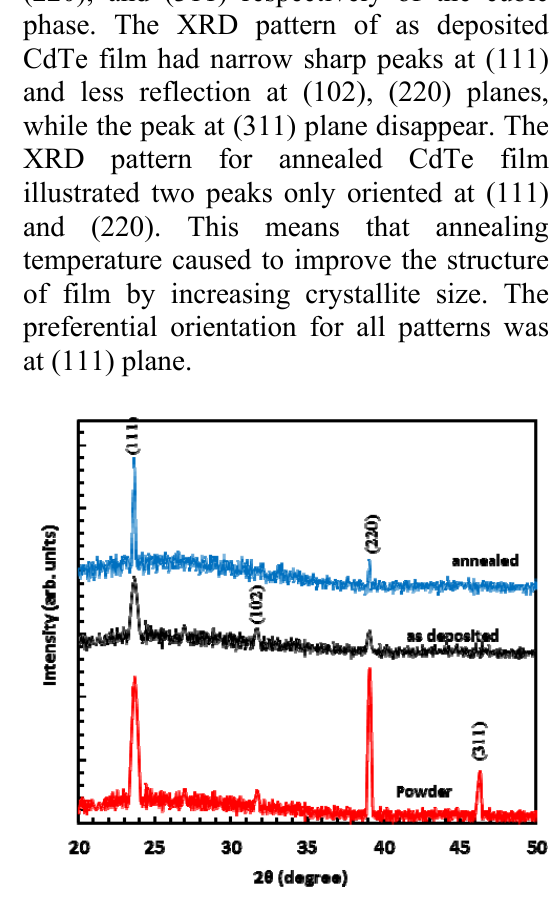
Fig. 1: The XRD pattern for CdTe powder and films as deposited and